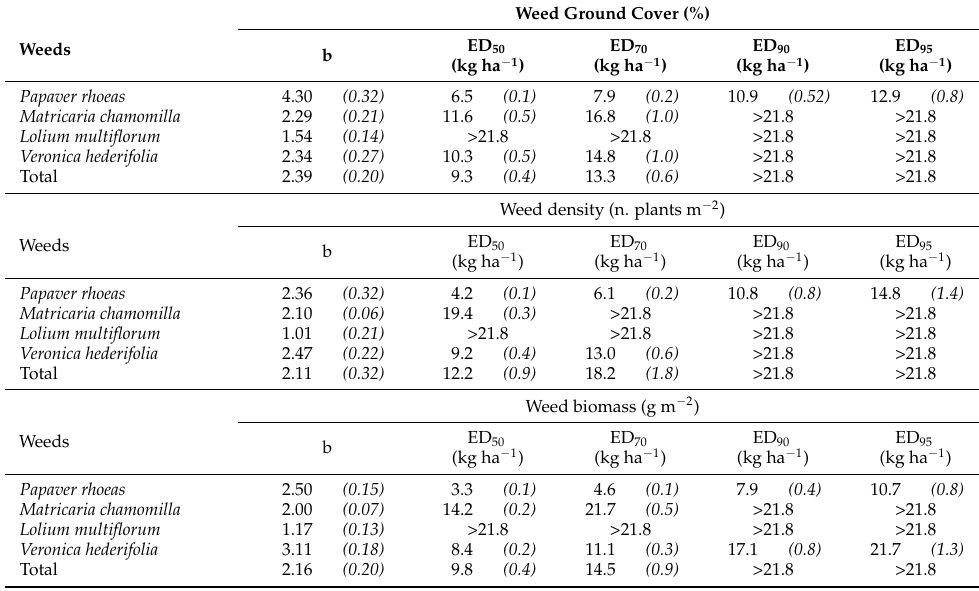
Table 2. Dose-response curves parameters (b, ED 50 , ED 70 , ED 90 , ED 95 ), based on weed ground cover, weed density, and weed biomass, calculated from the fitted equations in Figure 1. Standard errors are in parentheses.